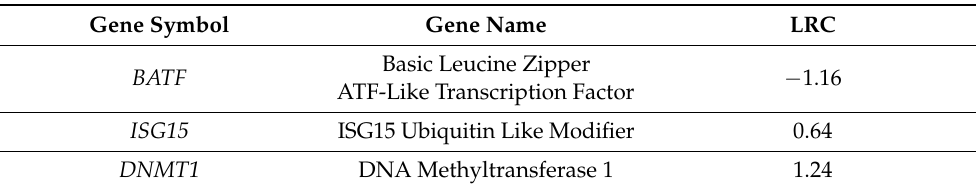
Table 3. Genes included in the viral vs bacterial 3-gene transcriptomic signature. LRC = logistic regression